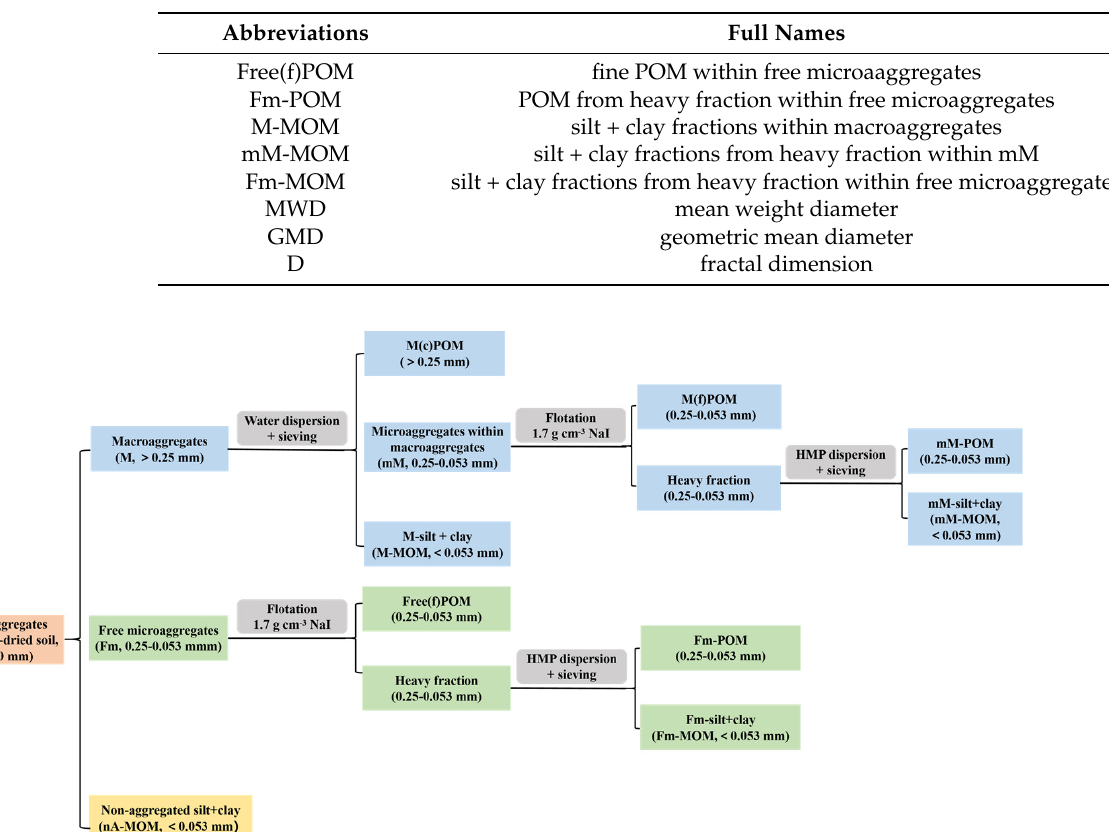
Figure 1. The procedure of soil aggregate classification. HMP, sodium hexametaphosphate. The specific meanings of organic matter fractions with abbreviations are presented in Table 1. Table 1. The abbreviations and full names of various organic matters and organic carbon fractions, and soil aggregate stability indicators.